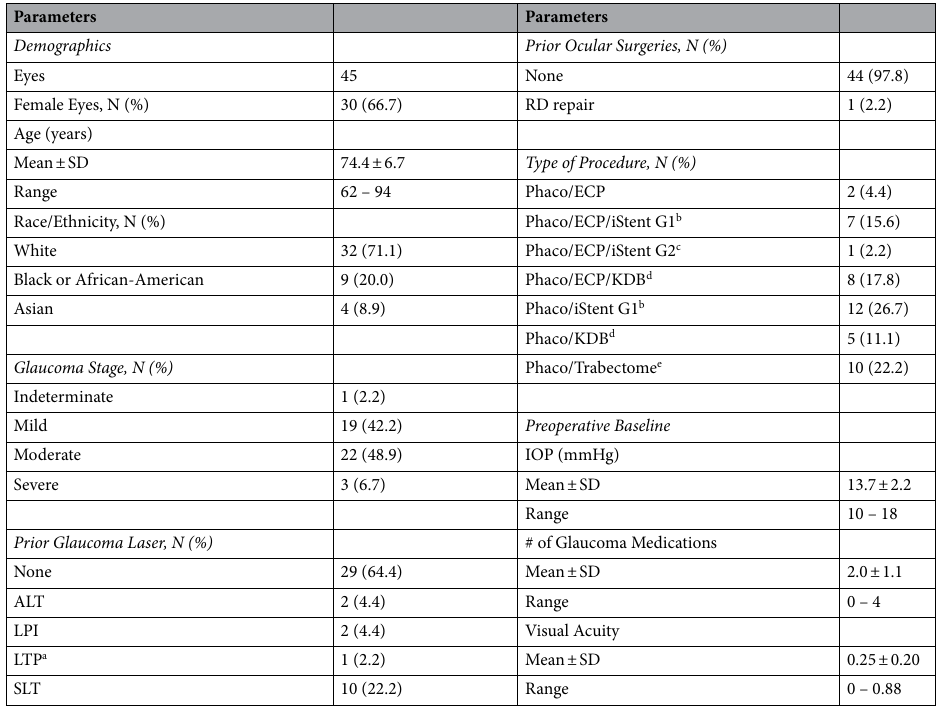
Table 1. Demographic and preoperative data. N = number of eyes; SD = standard deviation; IOP = intraocular pressure; mmHg = millimeters of mercury; Phaco = phacoemulsification; ALT = argon laser trabeculoplasty; LPI = laser peripheral iridotomy; LTP = laser trabeculoplasty; SLT = selective laser trabeculoplasty; RD = retinal detachment; ECP = endoscopic cyclophotocoagulation; G1 = Generation 1; G2 = Generation 2; KDB = Kahook Dual Blade. a This patient could not recall the type of LTP performed, and no records were available from then. b iStent Trabecular Micro-Bypass Stent (Models GTS100R and GTS100L, Glaukos Corporation, San Clemente, California). c iStent inject Trabecular Micro-Bypass System (Model G2-M-IS, Glaukos